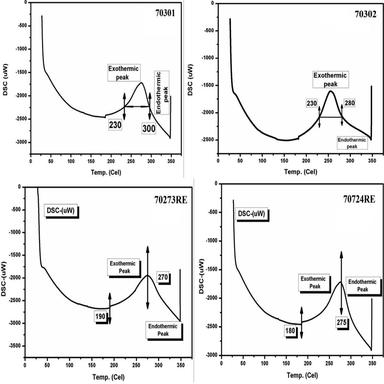
Results of DSC of all four NEG alloys.